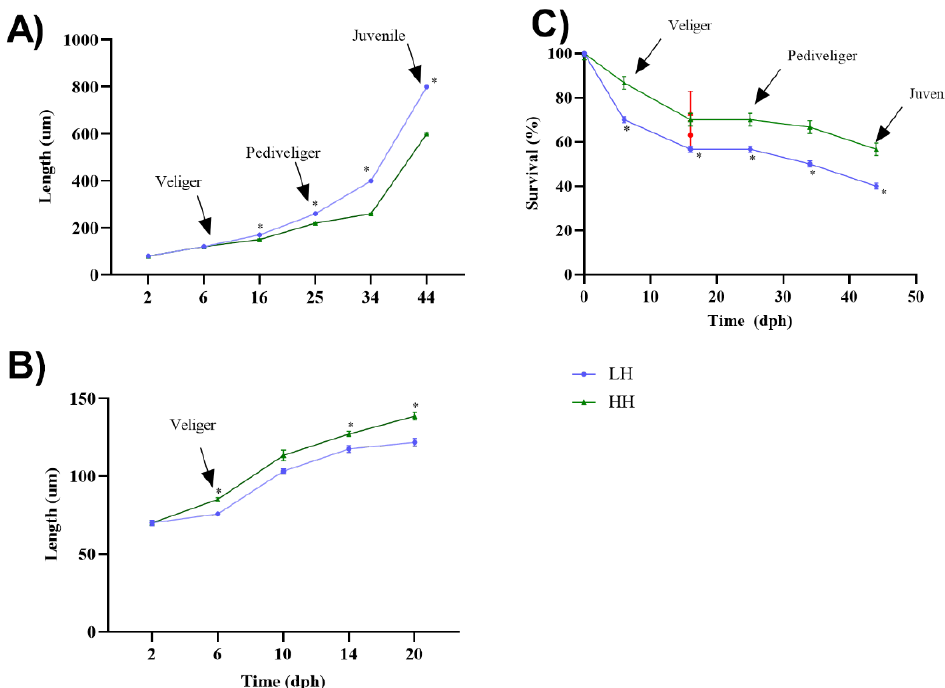
Figure 6. Growth and survival rates of Argopecten purpuratus larvae and early juveniles fed diets low (LH) and high (HH) in HUFAs. Growth rates are shown for two cultures; ( A ) the density was not adjusted and ( B ) the density was adjusted according to the differential survival rate observed in each dietary treatment. The survival rate ( C ) for both cultures is presented in the same graph (second culture indicated by the red line). Asterisks (*) indicate significant differences between dietary treatments at each developmental stage ( p <